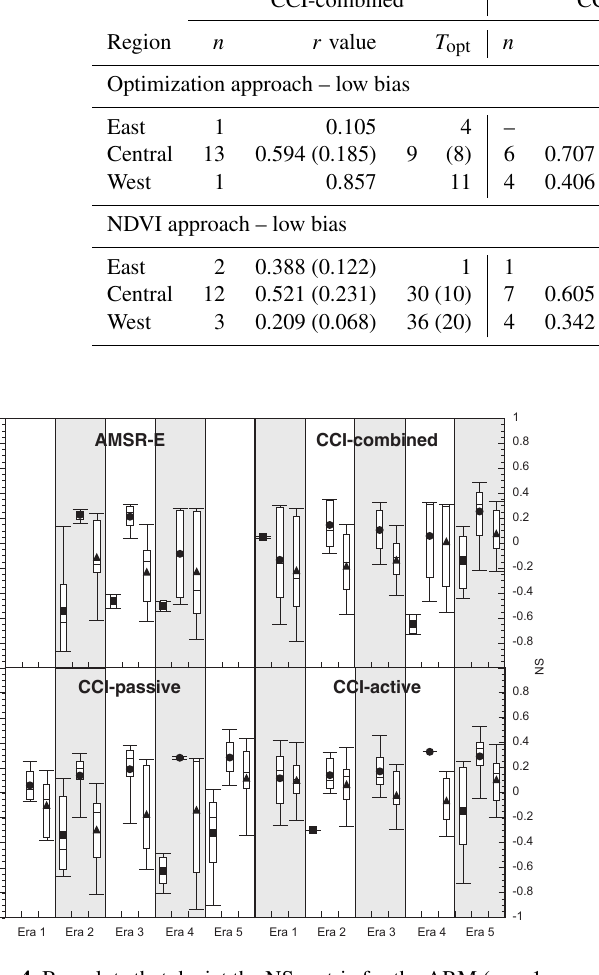
Figure 4. Box plots that depict the NS metric for the ARM (eras 1– 4) and USCRN (era 5) networks. Results for high absolute bias RMSE-optimized datasets are squares, low absolute bias RMSE- optimized datasets are circles, and low absolute bias NDVI datasets are triangles.